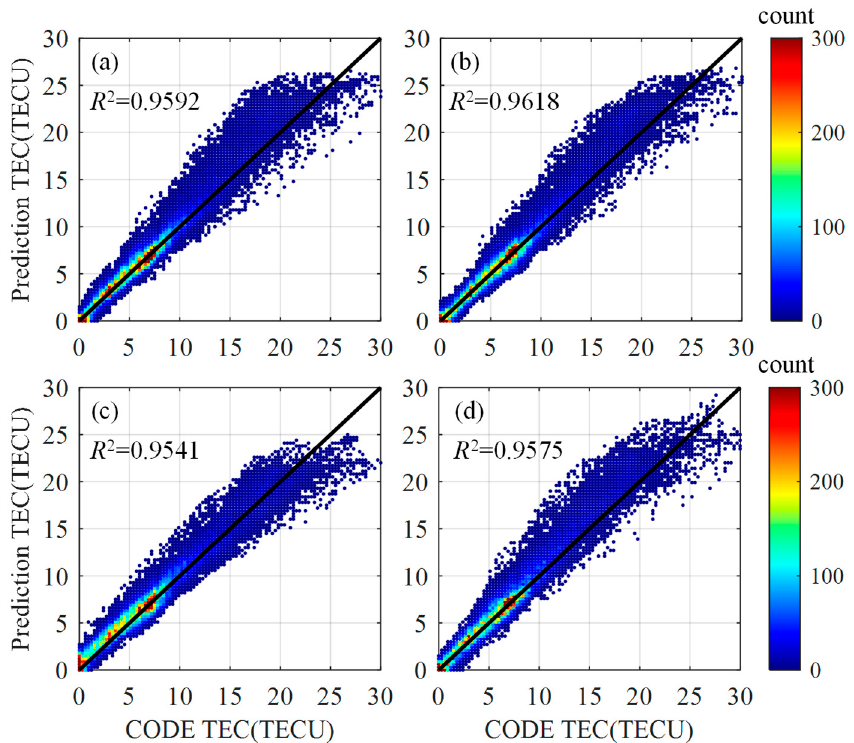
Figure 3. Correlation analysis between forecasted values and CODG values on 1 June in a year of low solar activity. ( a – c ) Scatter density plots of the correlations between the 7-day, 15-day and 30-day Prophet model forecasted values, respectively, and the CODG values. ( d ) Scatter density plot of the correlation between the COPG and CODG values.